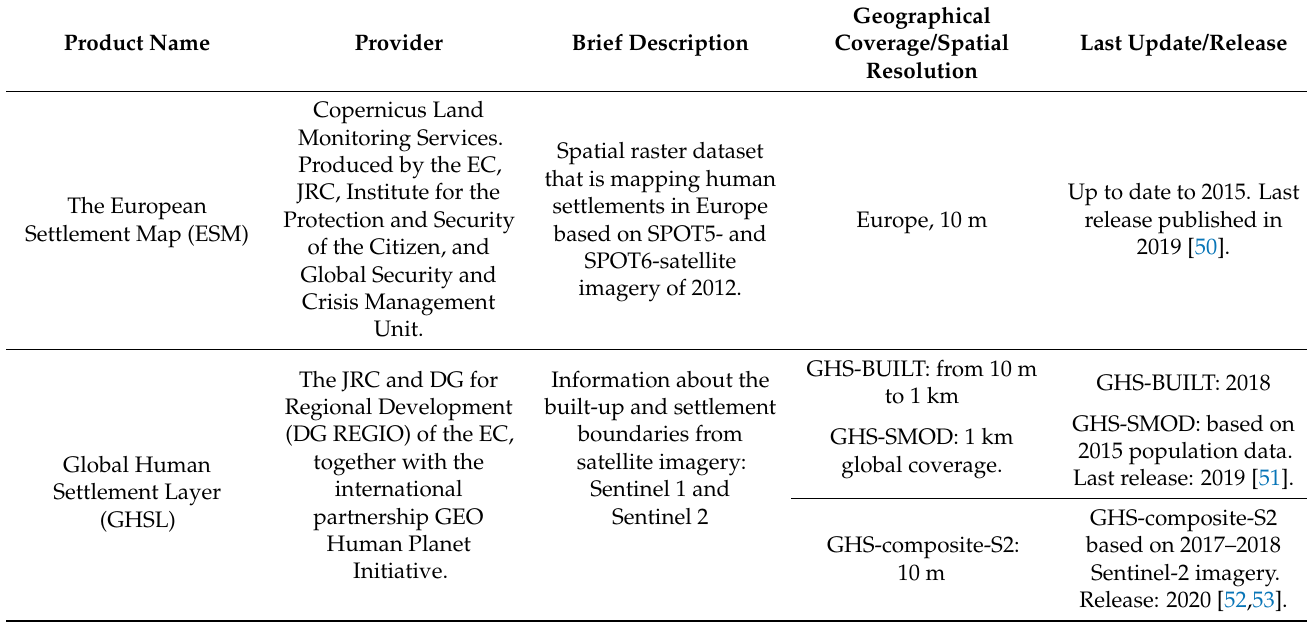
Table 1. The collection of EO-based cities and settlement datasets from EU